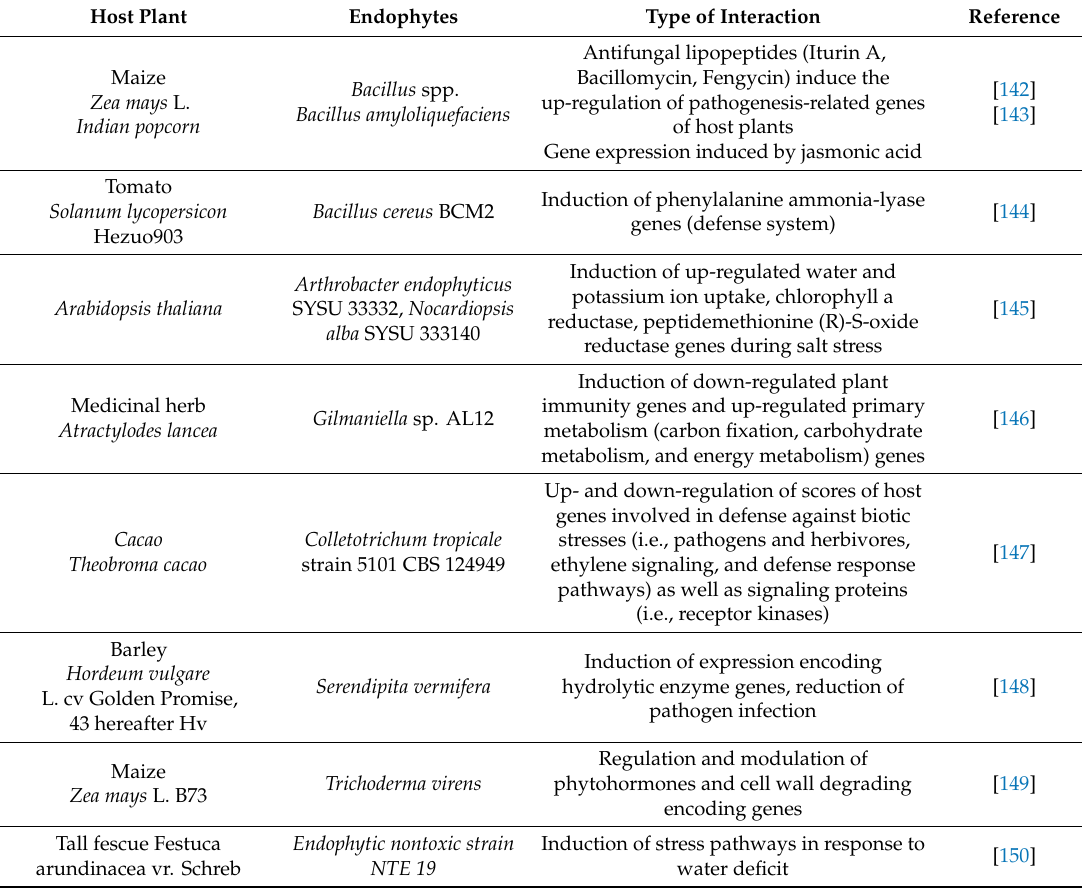
Table 5. Examples of endophytic strains, their host plant, synthesized bioactive compounds, and